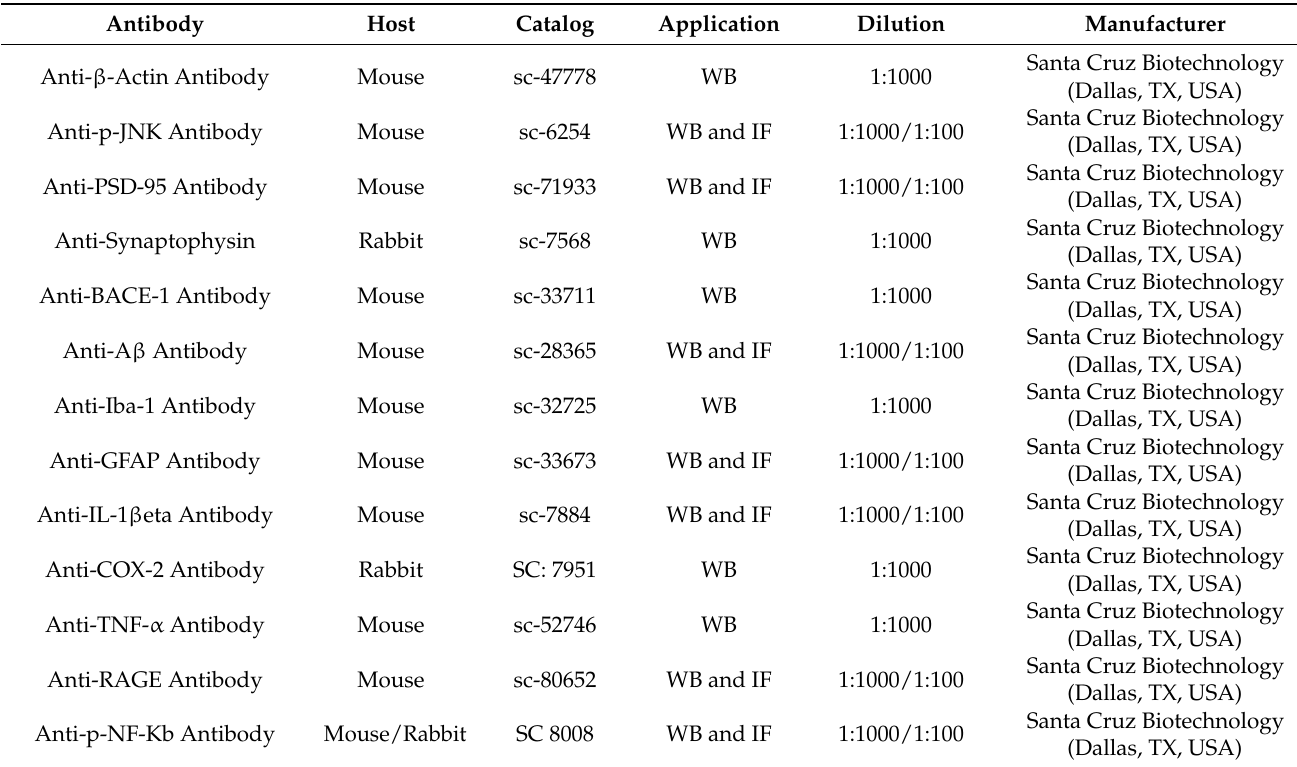
Table 1. A detailed list of antibodies and their information used for western blot and